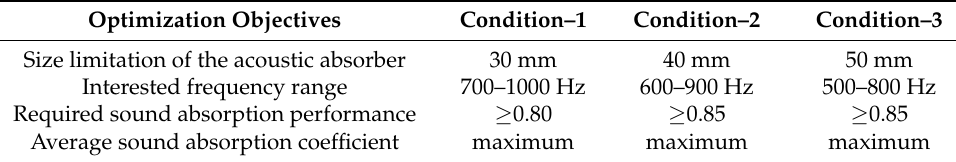
Table 2. The three requirements for noise reduction in the given factories.